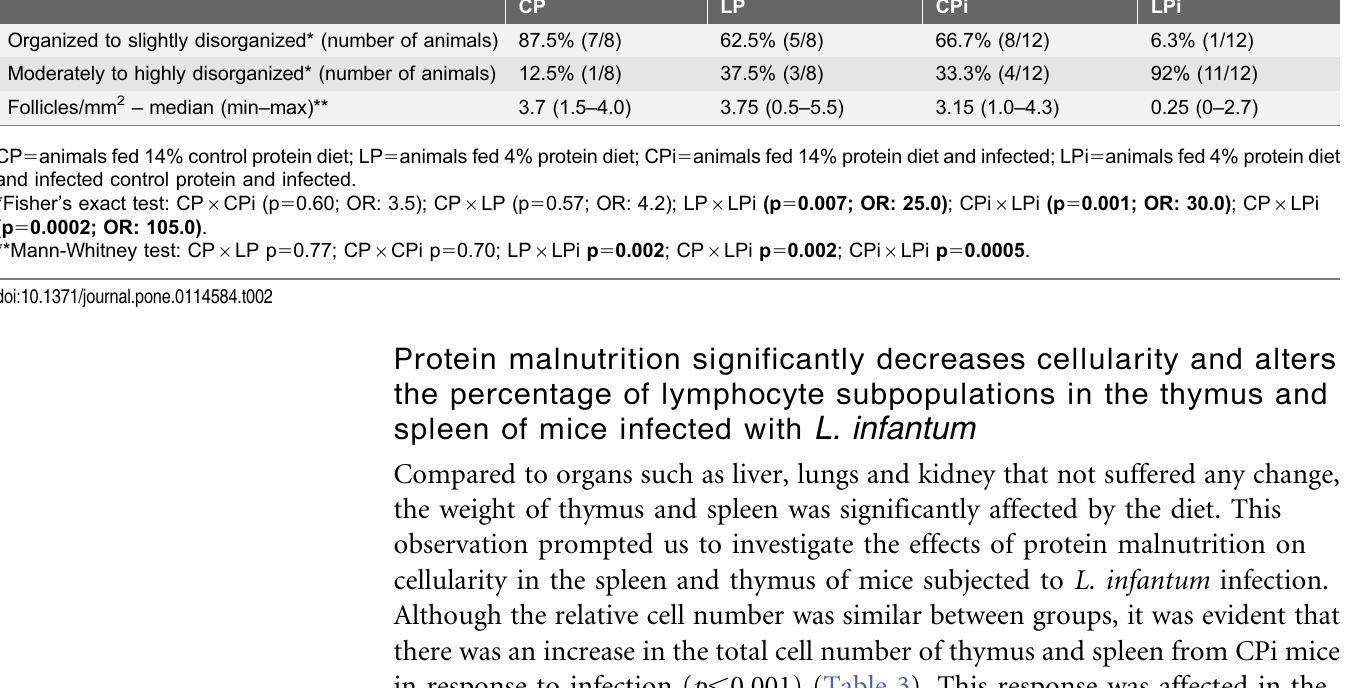
Table 2. Organization of the splenic white pulp in mice submitted to protein malnutrition and infected with Leishmania infantum . White pulp